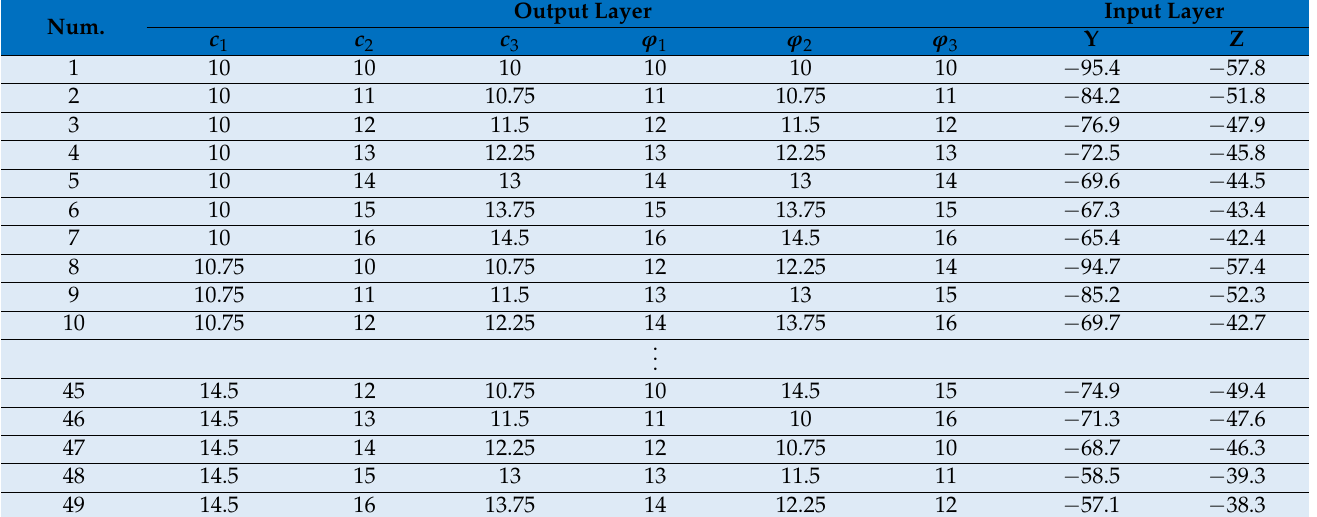
Table 3. Training